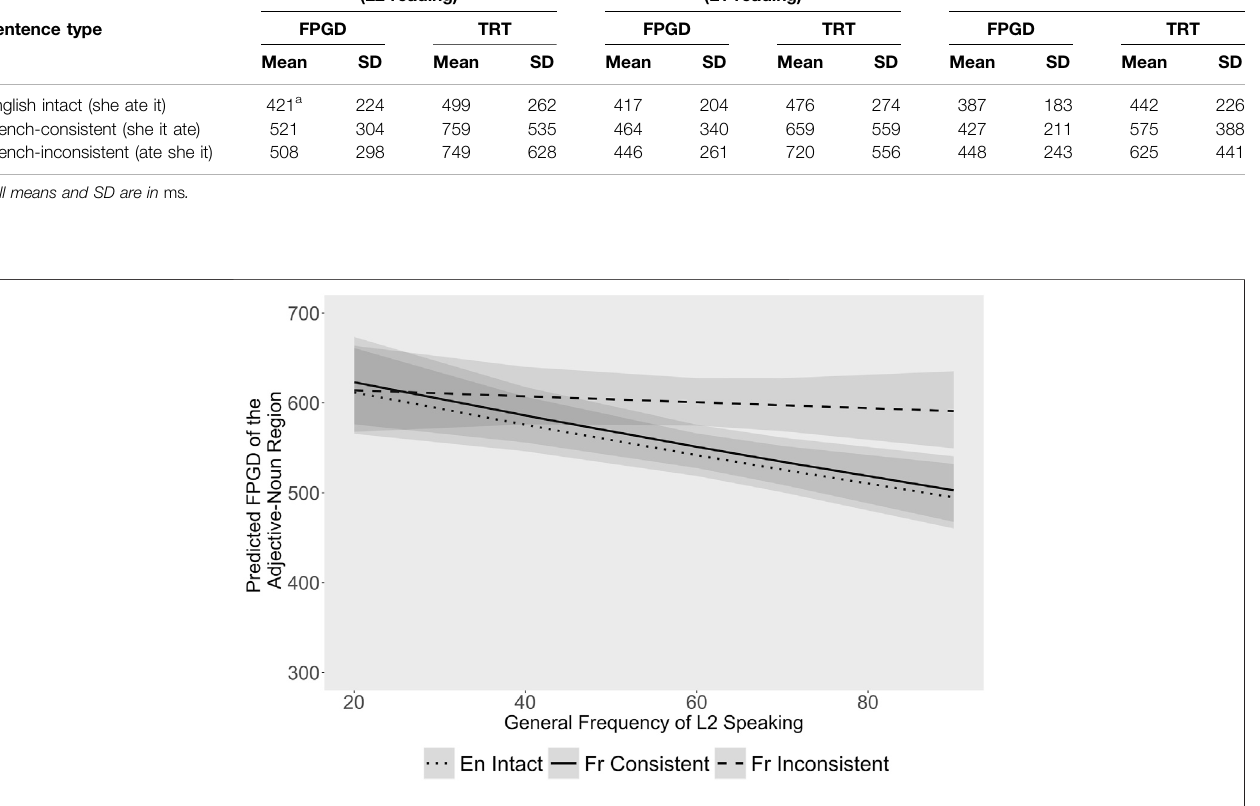
FIGURE1| Experiment 1(French-EnglishbilingualsreadinginL2),interaction effect ofgeneralfrequencyofL2speaking(out of100%)onpredicted fi rstpassgaze duration (in ms) of the adjective-noun region. Shaded area represents plus/minus one standard error of the mean.